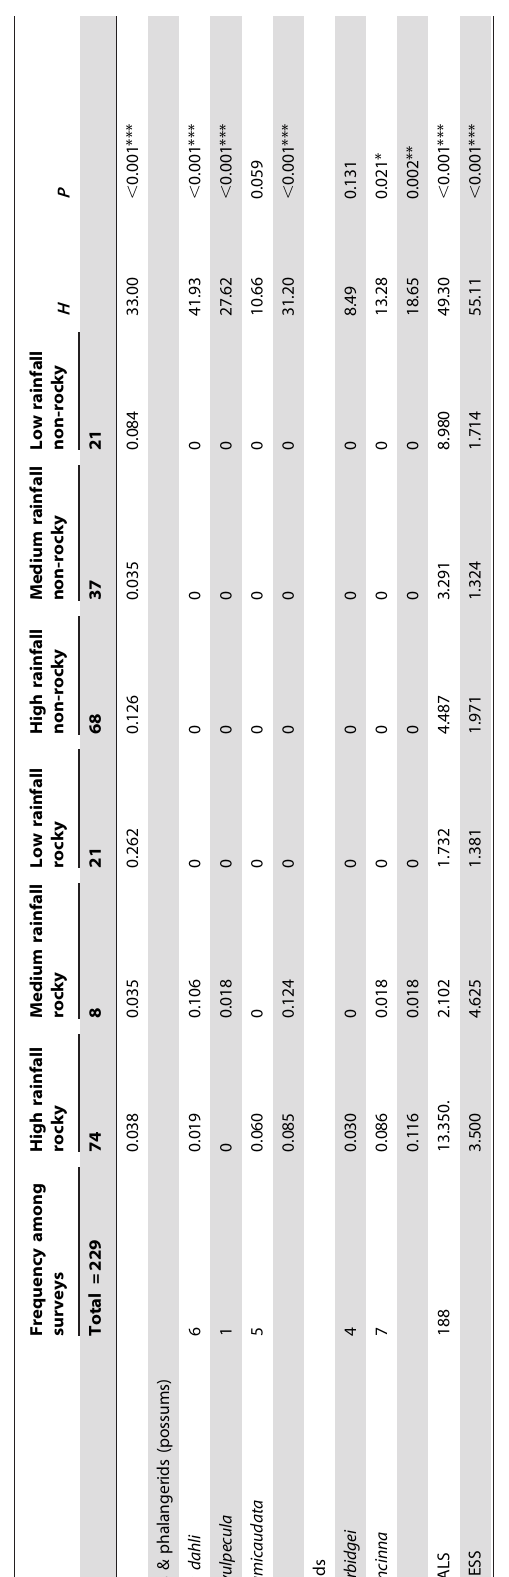
(Fig. 4). Zyzomys argurus, D. hallucatus, M. macrurus, I. auratus and